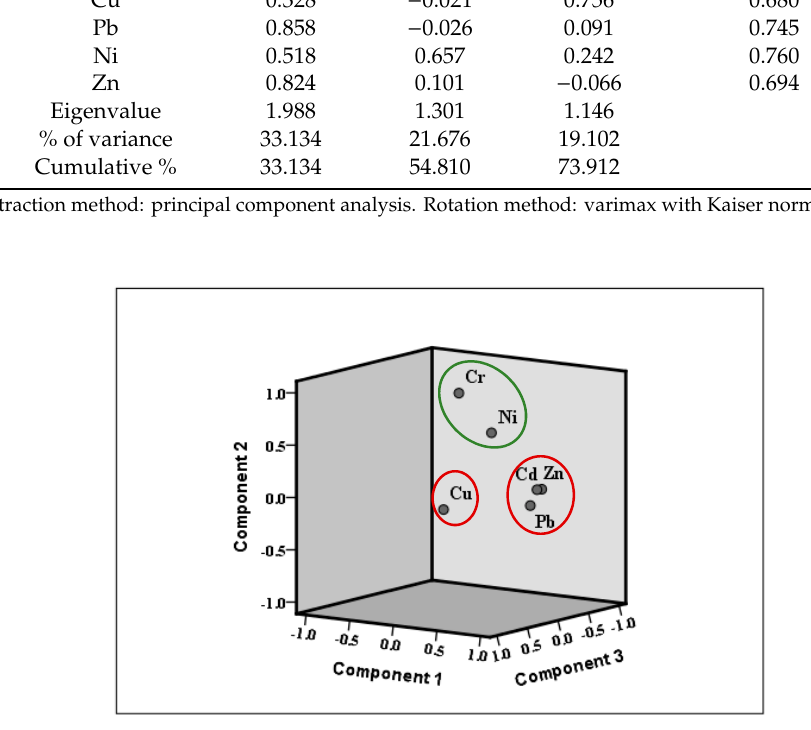
Figure 6. Box charts for accumulation index and potential hazard index. The E r and RI results for the study area (Figure 6) show that the average ecological risk index from Zn, Pb, Cu, Cr, and Ni is less than 40, indicating that the potential ecological risk is low. There are also three samples with Cu and six samples with Pb between 40 and 80, presenting low potential risk. The lowest value of Cd is 108, the highest value is 4531, and the average value is 562, indicating